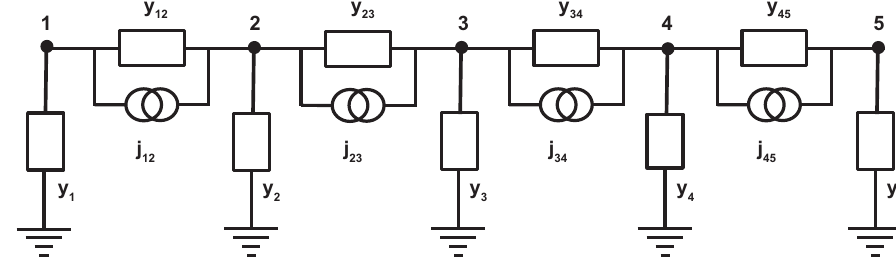
Fig. 4. Single-phase diagram of a power network illustrating nodes and admittances, y , and equivalent current sources,